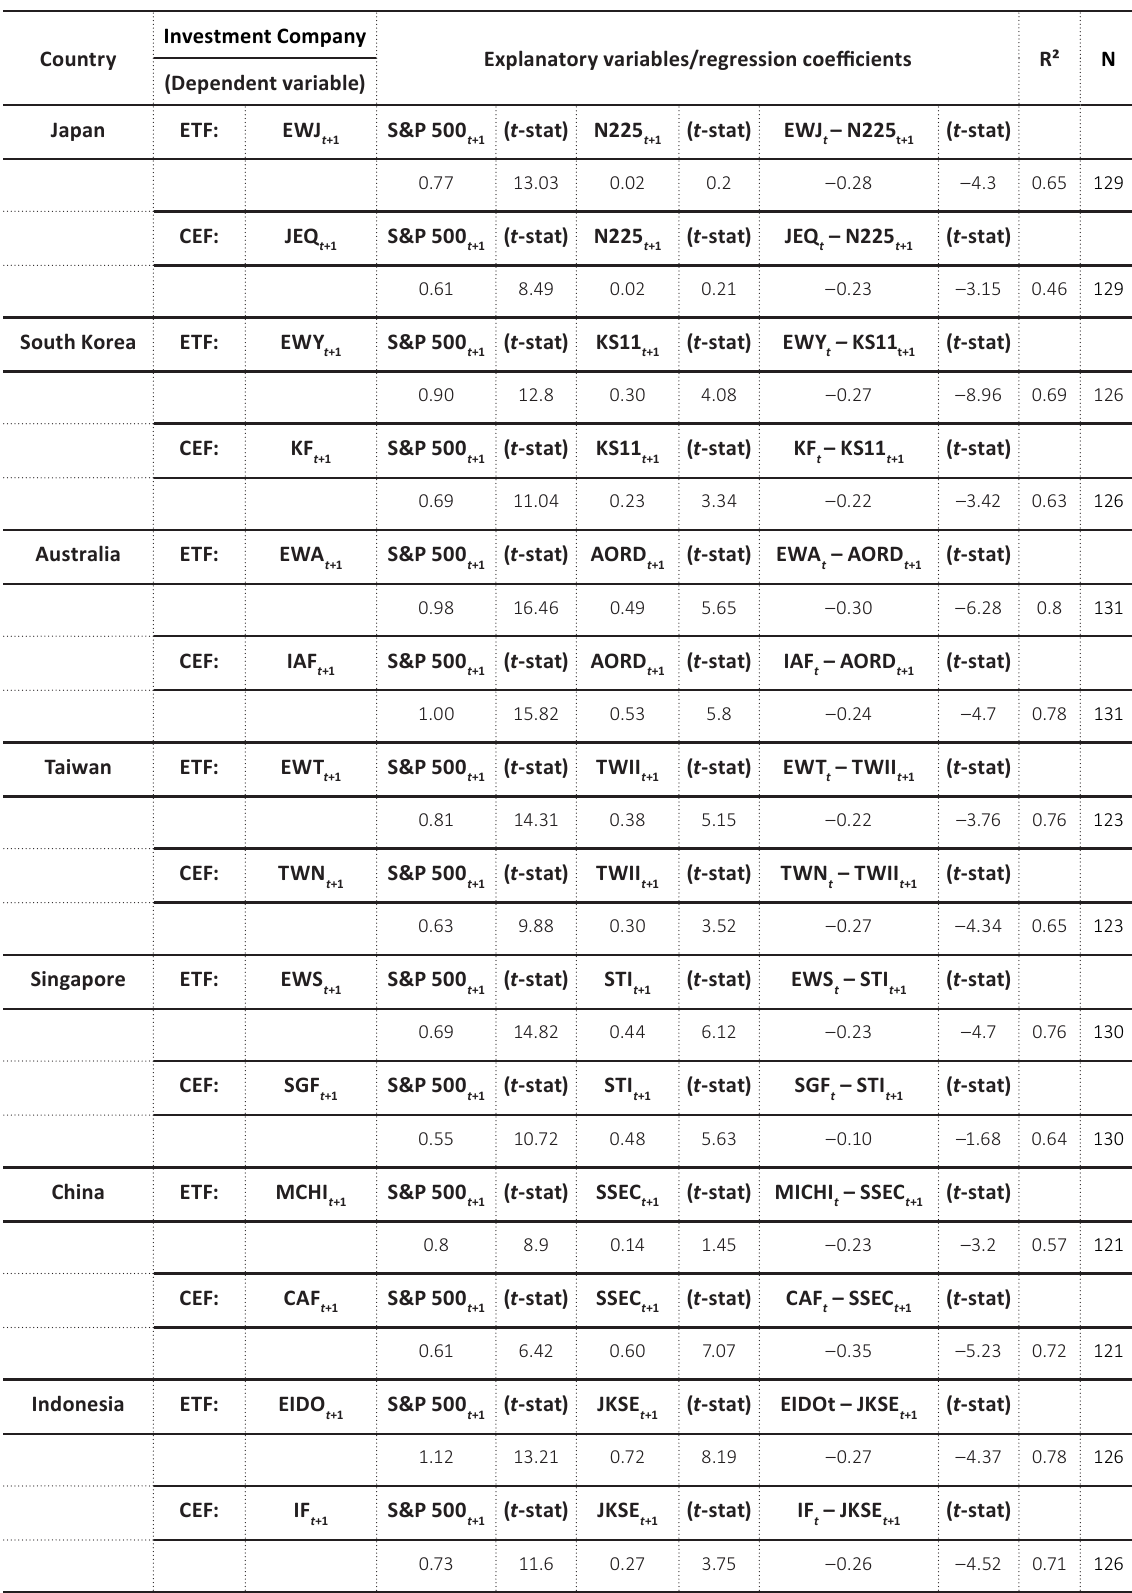
Table A2. Determinants of U.S. based Pacific Basin equity investment company returns – 2011–2015 (S&P 500 return ≤